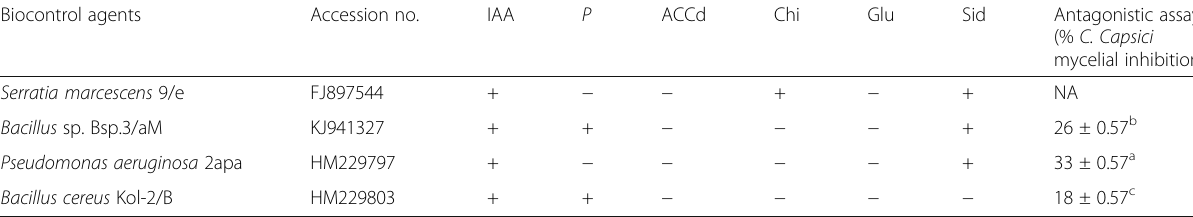
Biocontrol agents